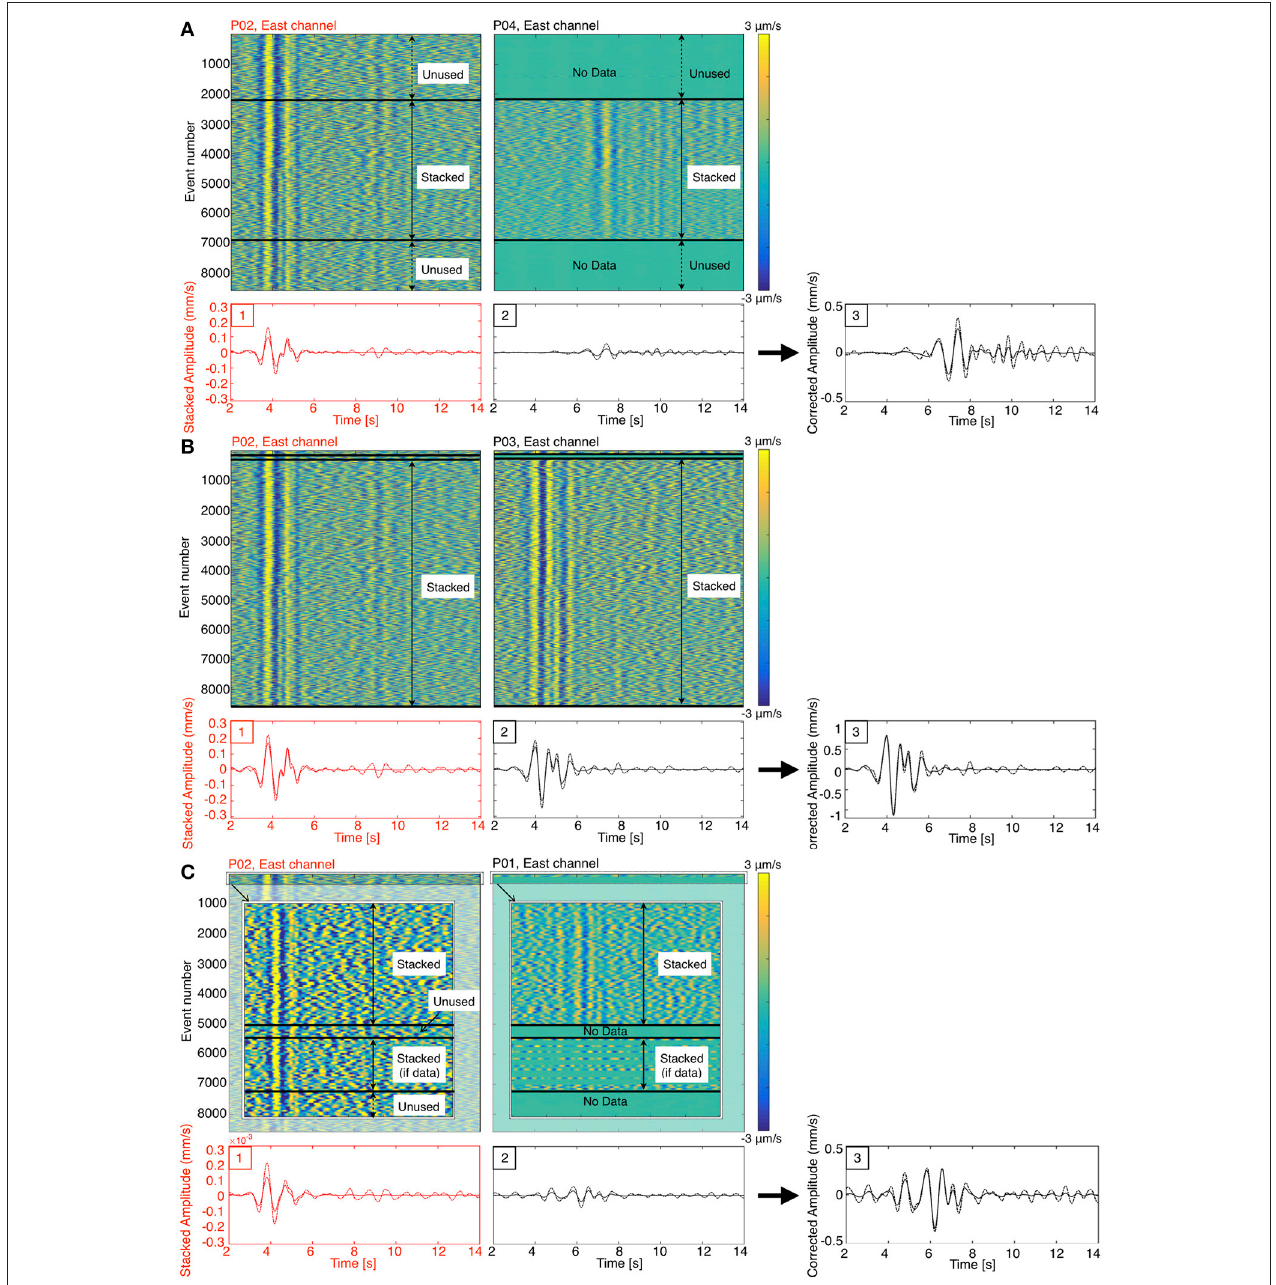
FIGURE 4 | Stacking procedure for east components of P02 and P04 (A), P02 and P03 (B), P02 and P01 (C). P02 is the reference station used for normalization. (A) top row: waveforms of events recorded at P02 and at P04; black lines indicate the stacking interval used for P04. Waveforms are bandpass filtered between 0.5 and 2.0Hz, and amplitudes are scaled appropriately to the color bar. Bottom row, panel 1: we show in red the phase-weighted (solid line) and linear (dashed line) stacks for P02 over the stacking interval of P04. Bottom row, panel 2: we show in black the phase-weighted (solid line) and linear (dashed line) stacks for P04. In panel 3, we show the phase-weighted and linear stacks of the east component waveform for P04 with amplitude normalized by the maximum absolute amplitude of the P02 stack over the stacking interval station P04. (B) and (C) same as (A) but for stations P03 and P01 respectively.